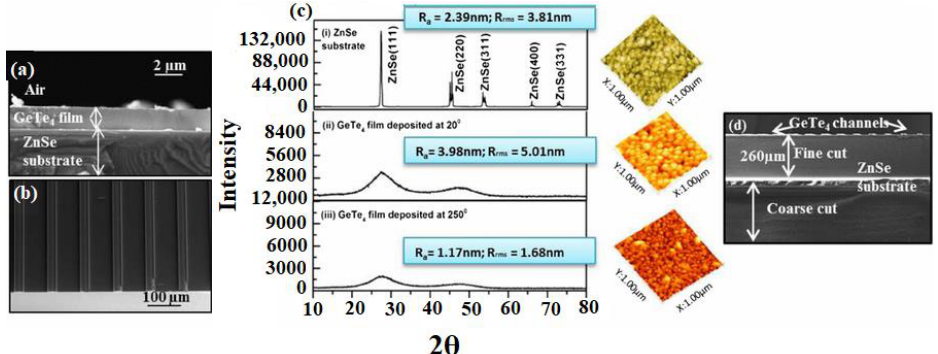
Figure 7. ( a ) SEM image of a cleaved cross-section of GeTe 4 film as deposited; ( b ) top view of GeTe 4 channels fabricated using lift-off techniques; ( c ) X -ray diffraction pattern and atomic force microscopy image of a ZnSe substrate and GeTe 4 films. ( d ) Distal coupling facet of the waveguide cut by ductile dicing [109]. Reproduction requires permission from the Optical Society Publishing, 2015. These third-generation waveguides are amorphous and yield a MIR window in the spectral region of 2 – 20 mm. Even though a single-mode nature is aspired to for many sensing investigations, a GeTe 4 waveguide layer with channels can exhibit a multimode behavior for specific wavelength regions. Subsequently, these materials and manufactur- ing methods could be employed to obtain single-mode conduct [109]. The combination of the specific applications.